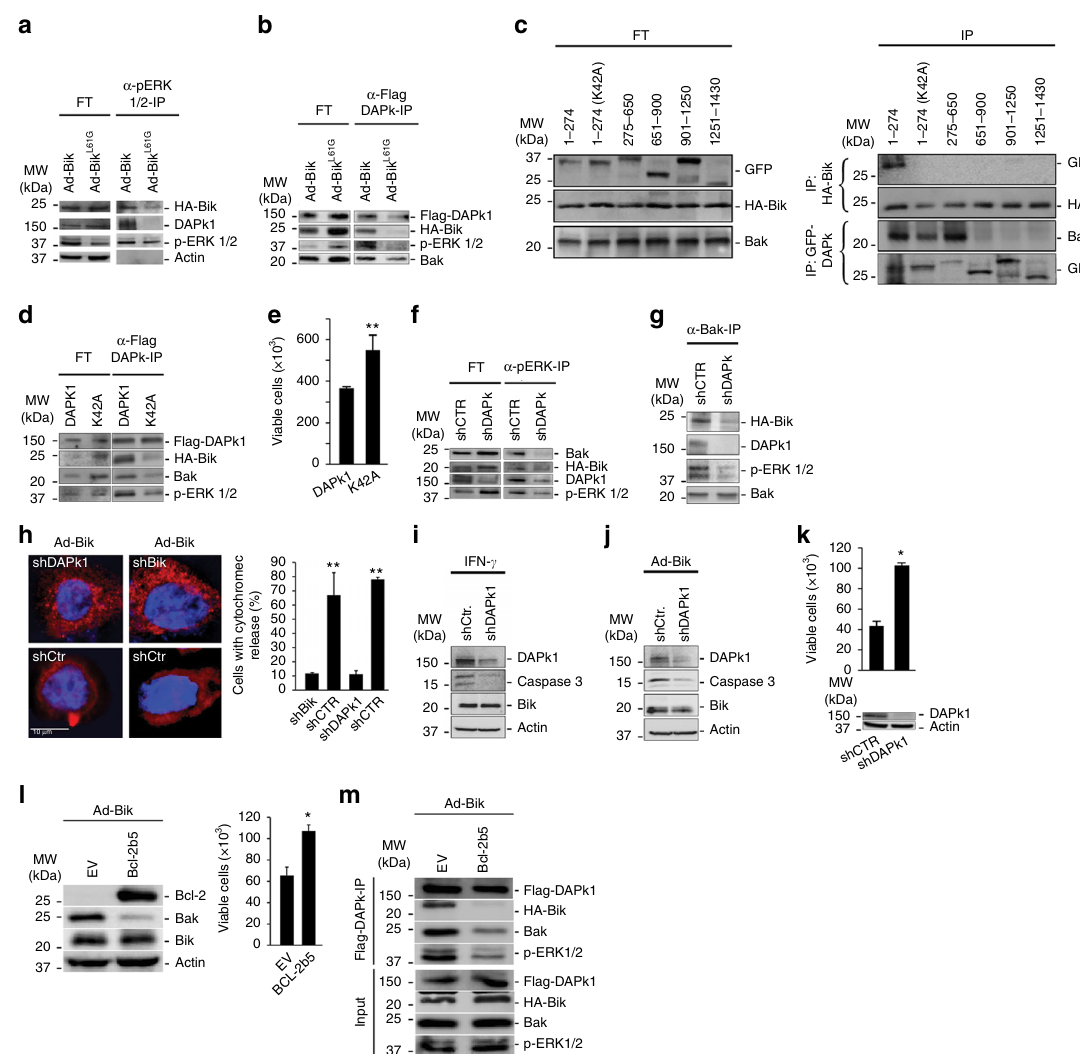
Fig. 3 DAPk1 facilitates Bik-induced cell death by forming a complex with Bik, ERK1/2 and Bak. a Protein lysates from HAECs 24 h after infection with HA- Ad-Bik or HA-Ad-Bik L61G were immunoprecipitated with anti-pERK1/2 antibodies. The fl ow through (FT) and the immunoprecipitates (IPs) were probed with antibodies to HA, DAPK1, p-ERK1/2, and ERK1/2 by western blotting. b 293T cells were transfected with Flag-DAPk1 and 48 h later infected with 100 MOI HA-Ad-Bik or HA-Ad-Bik L61G . After 24 h, protein lysates were immunoprecipitated with α -Flag antibodies and the FT and IP were probed for activated Bak, HA, and ERK1/2 by western blotting. c 293T cells transfected with various GFP-tagged DAPk1 deletions constructs, infected with HA-Ad-Bik, and subjected to immunoprecipitation using anti-HA or anti-GFP antibodies. The fl ow through (FT) and the IPs were probed for GFP, HA, activated Bak. d Mutation of Lys42 in the kinase domain of DAPk1 diminishes Bik – Bak – DAPk1 – ERK1/2 interaction. 293T cells were transfected with Flag-DAPk1 or Flag- DAPK1 K42A and 48 h later infected with 100 MOI HA-Ad-Bik. Protein lysates were immunoprecipitated using α -Flag antibodies and the FT and IP were probed for Flag, HA, Bak, and ERK1/2 by western blotting. e Cell viability of 293T cells transfected with Flag-DAPk1 or Flag-DAPK1 K42A was analyzed by trypan blue assay. f , g Knockdown of DAPk1 suppresses the interaction between Bak, Bik, and ERK1/2. Protein lysates from HAECs stably expressing shCtr or shDAPk1 were infected with HA-Ad-Bik and immunoprecipitated using anti-pERK1/2 f or anti-active Bak (Ab1) g antibodies. The FT and IPs were